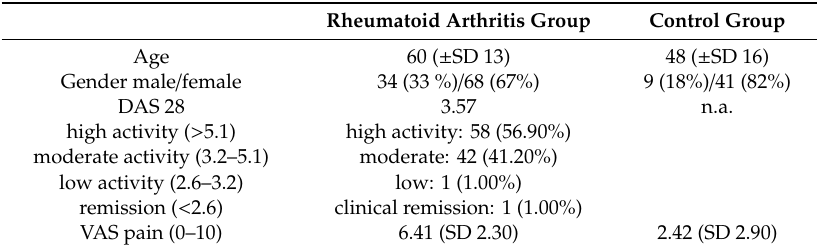
Table 1. Patient